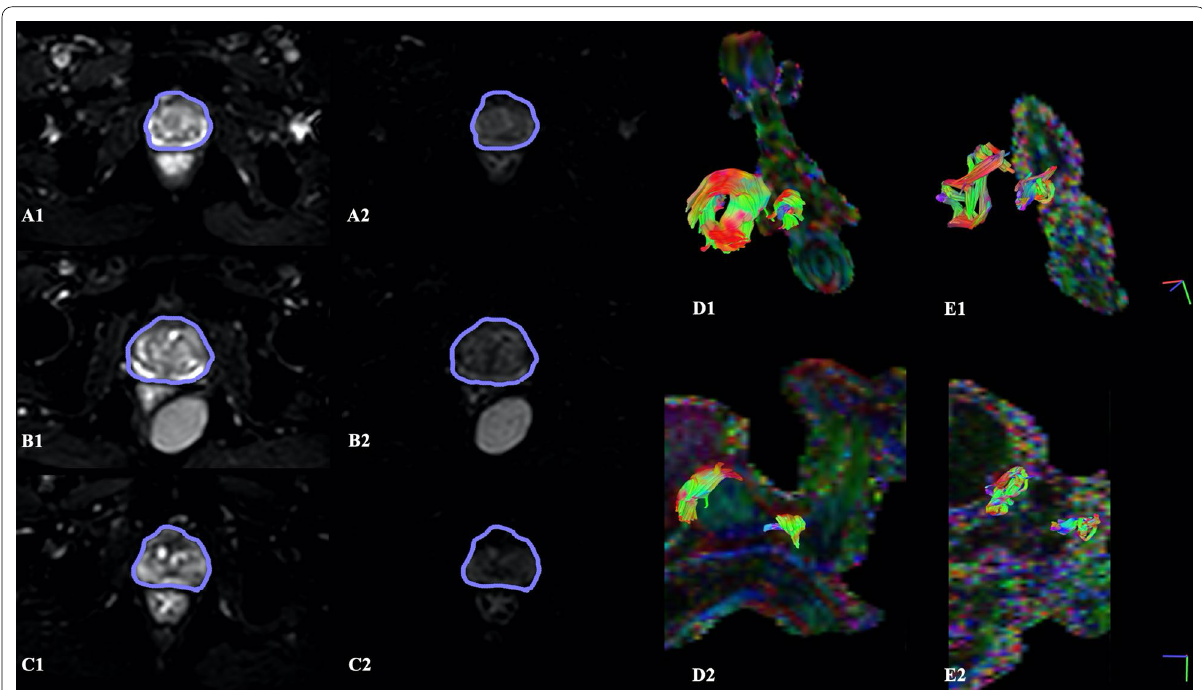
Fig. 3 On the left, three patients with diffusion-weighted images at the level of the prostate with its contour manually traced on the baseline b 0 s/mm 2 image (left column), overlaid on the b 600 s/mm 2 at the corresponding location (right column), to verify that eddy currents did not = = significantly caused distortions on the prostate. On the right, comparison of fiber tracking results for the sphincters and membranous urethra using two different combinations of acquisition parameters: (1) b value of 600, 15 directions, 40 acquired slices ( D1 and D2 , from two different views); (2) b value of 800, 32 directions, 25 acquired slices ( E1 and E2